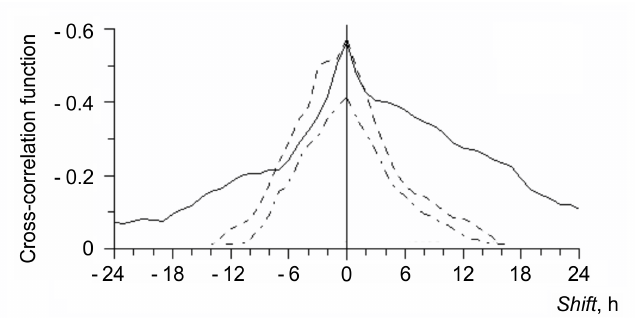
Figure 5. Cross-correlation functions for the average hourly values of atmospheric electric field potential gradient and acoustic pressure in the experiments 2006 (solid line), 2007 (dashed line) and 2008 (dot-dash